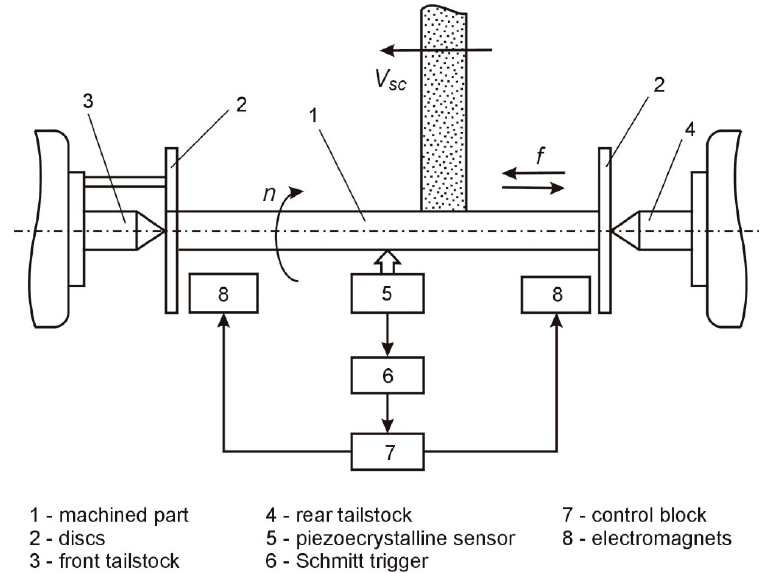
Figure 5. Block diagram of measurement and compensation of bending vibrations during grinding.